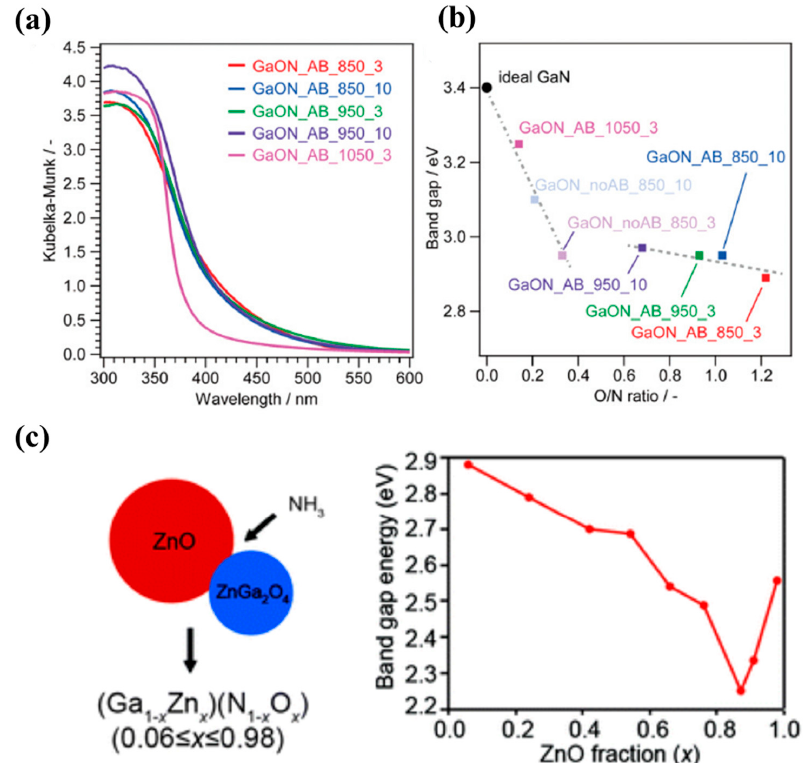
Figure 3. ( a ) UV-vis DRS spectra of the (Ga 1 − x Zn x )(N 1 − x O x ) samples. ( b ) Relationship between the O/N ratio and the band gap of (Ga 1 − x Zn x )(N 1 − x O x ), [58] and ( c ) the relations between bandgap energies and ZnO fraction ( x ) in (Ga 1 − x Zn x )(N 1 − x O x ) solid solutions [59]. (Reproduced from Refs. [58,59] with permission from the RSC).